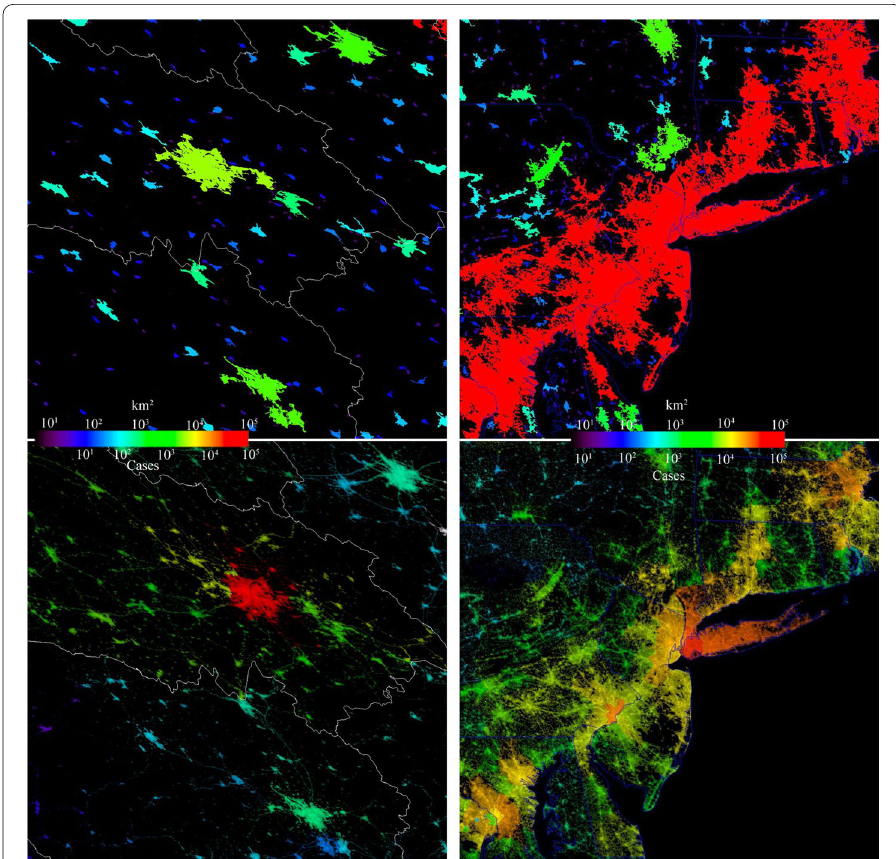
Fig. 6 Full resolution comparison of network component area and total confirmed case distributions for Wuhan (left) and the US Northeast Corridor (right). Despite very different network configurations, both examples show spatial gradients in number of confirmed cases with distance from a central hotspot (Wuhan & NYC), however the much larger Northeast Corridor shows strong gradients and multiple local maxima within a single connected component while the smaller components surrounding Wuhan show much smaller numbers of cases. While the Northeast Corridor component is large relative to the spatial gradient in cases, the Wuhan component is much smaller and comparable to the scale of the gradient observed in the NYC hotspot. The distributions are also a result of the disparity in spatial resolution between the 700 m VIIRS resolution and the widely varying sizes of county administrative units within which case counts are aggregated. Each area 500 500 ×